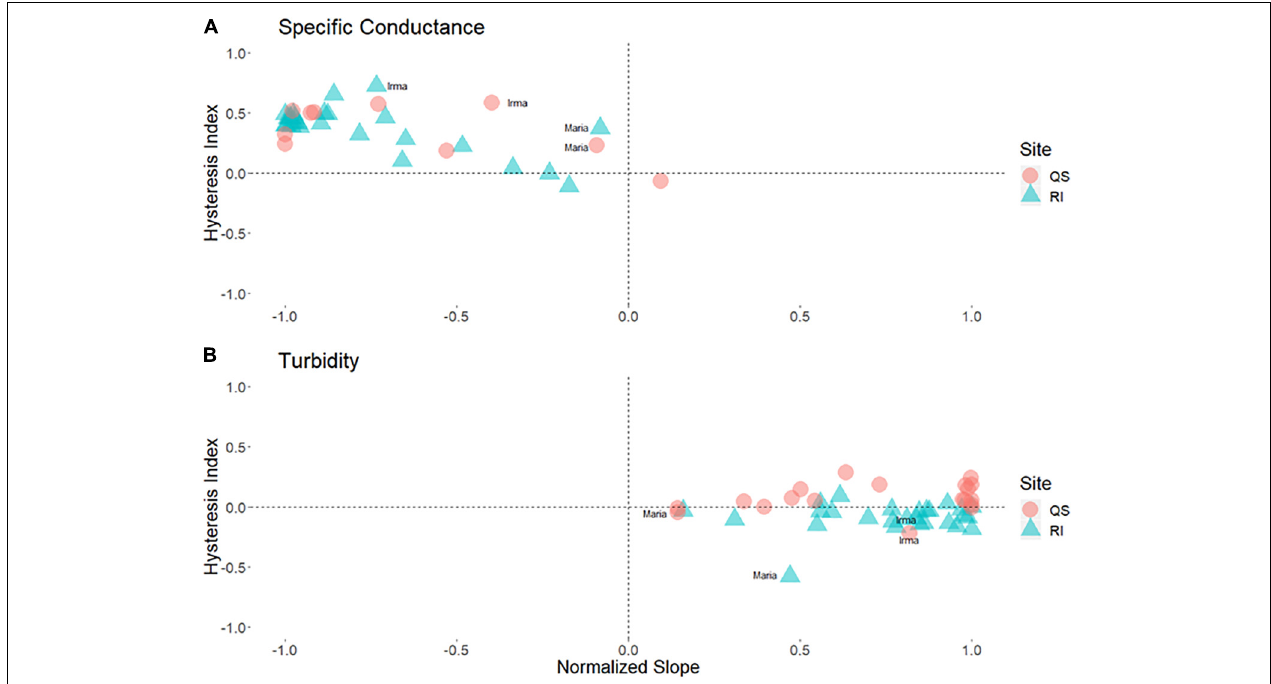
FIGURE 3 | Plots of (A) specific conductance and (B) turbidity storm HI versus storm normalized slope at both Quebrada Sonadora (QS) and Rio Icacos (RI). Upper-left hand quadrants represent a clockwise diluting response; upper right-hand quadrants represent a clockwise flushing response; lower left-hand quadrants represent counterclockwise diluting response; and lower right-hand quadrants represent a counterclockwise flushing response. The responses due to Hurricane Irma and Hurricane Maria are also labeled.